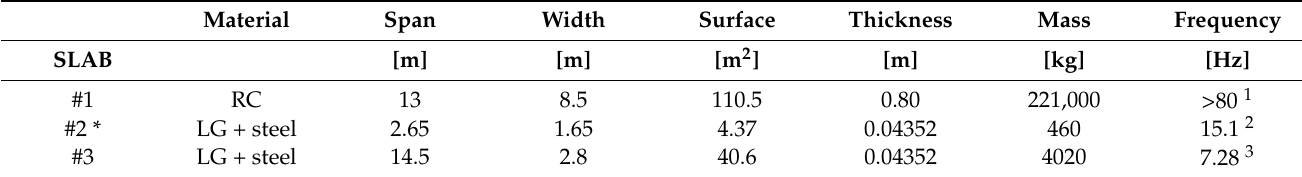
Table 2. Summary of structural features for normal walking experimental